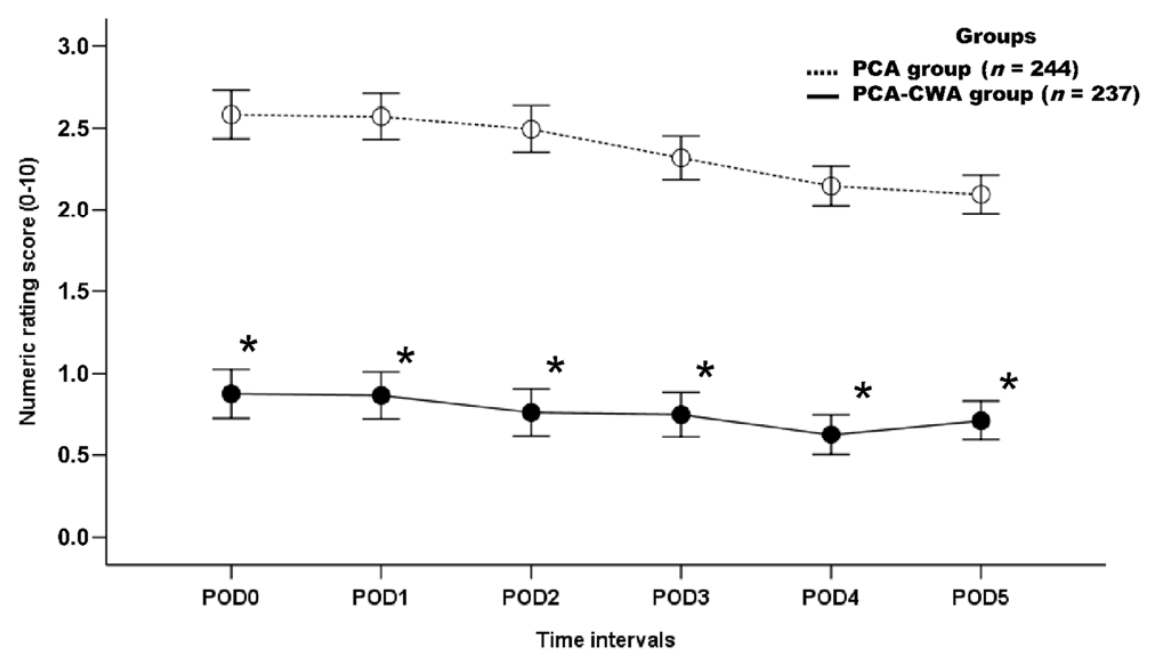
Figure 2. Numeric rating score over the 5-day postoperative course, before propensity score match- ing. POD, postoperative day; POD0, day of surgery. PCA group, group of patients who received postoperative intravenous PCA alone; PCA-CWA group, group of patients who received post- operative intravenous PCA and continuous wound infusion analgesia. * p < 0.05 is considered statistically significant.